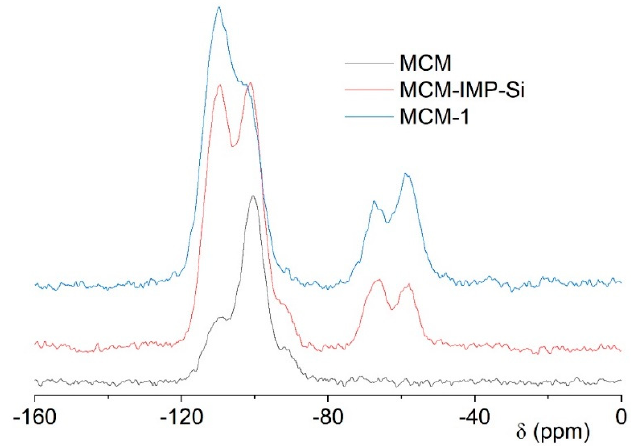
Figure 7. 29 Si CP MAS NMR spectra for the materials MCM, MCM-IMP-Si, and MCM-1.